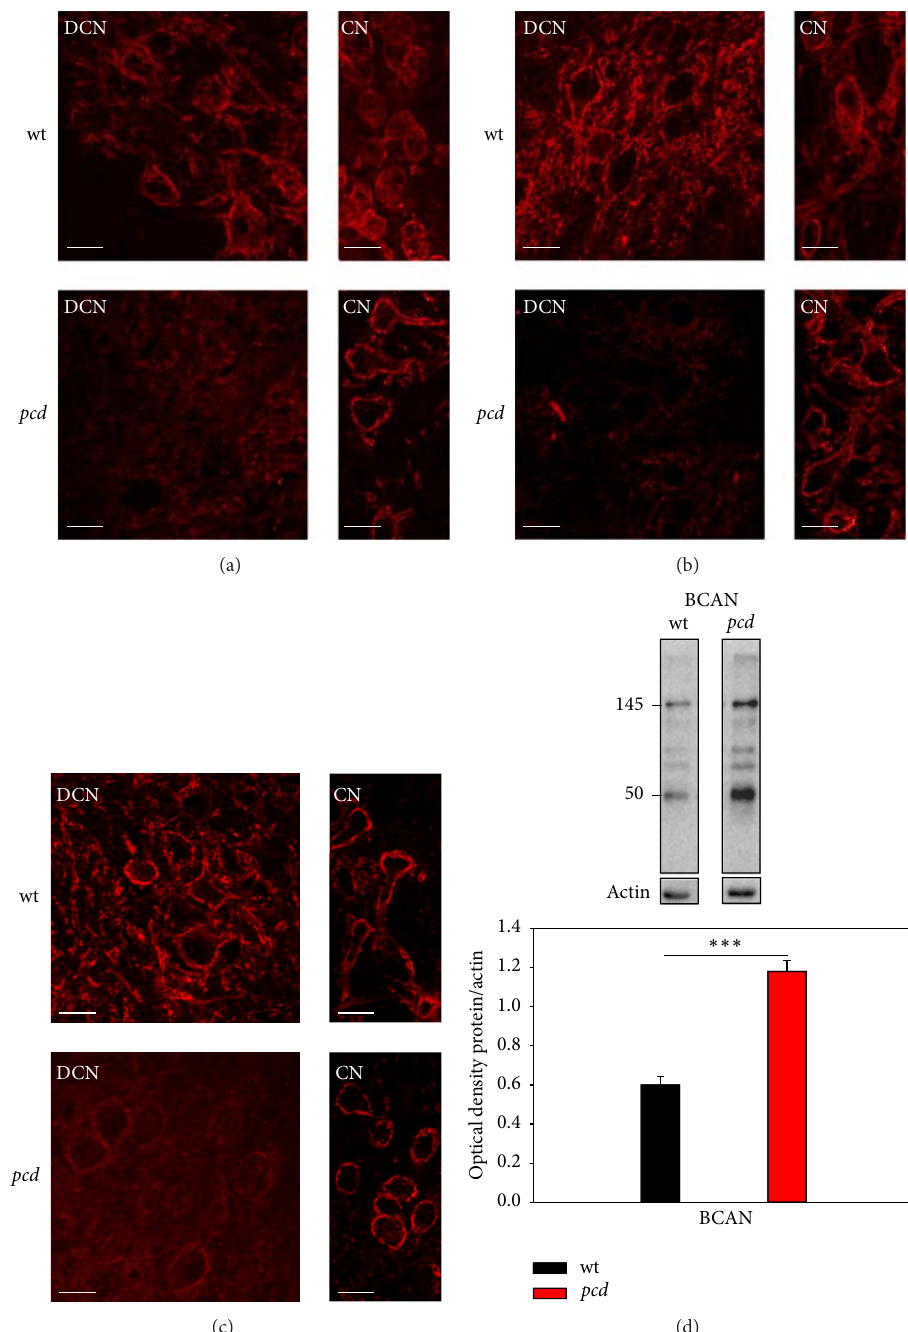
Figure 4: Detection of different brevican fragments. (a) Immunoreaction with pan-specific brevican antibodies (BD Bioscience, FL) clearly surroundsDCNneuronsin wt butnotin pcd mice.AsinternalcontrolnontargetregionofPCaxons,thecochlearnucleusshowsnoalterations in immunoreactions with FL. (b) The 50kDa isoform of brevican seems to be nearly absent around DCN neurons of pcd mice, whereas the not affected region (CN) revealed brevican-bearing neurons. (c) The B756 antibodies detect mainly the 80/90 kDa and full length isoforms of brevican. These cleavage products aggregate around the neurons in DCN of wt mice and seem to be integrated in PNs. In pcd , PNs appear with lower intensity, but with potential higher parenchymatic reaction. PN-detection with all three antibodies in the internal nontarget control region (CN) is unchanged. Scale bar: 20 𝜇 m. (d) Biochemical detection of brevican with SDS-PAGE with pan-specific antibodies revealed most known isoforms at 50, 80, 90, and 145 kDa. Quantification of the 50 and 145 kDa brevican isoform showed a significant increased protein expression in pcd ( 𝑝 < 0.001 ), respectively, for the different isoforms. Therefore, the diagram is supposed to display the optical density (OD) values of pan-brevican chemiluminescent signal summed values (OD 50 kDa + 145kDa brevican/actin). Data are given as mean ±